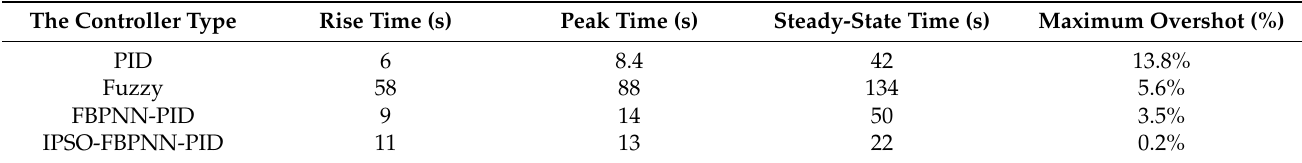
Table 4. Table of performance parameters for pH from 6.9 to